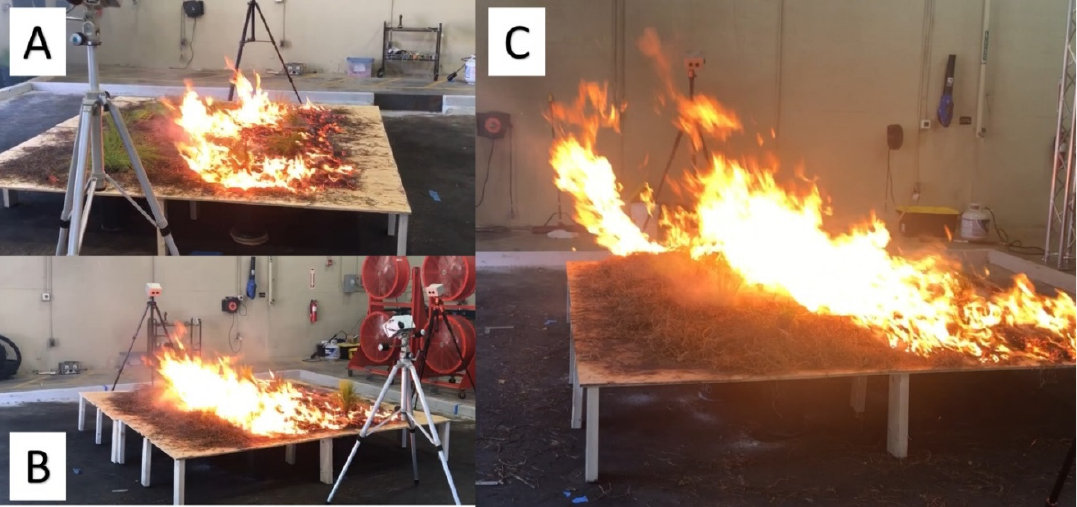
Figure 1. Low, medium, and high fuel loads after ignition. ( A ) Burn platform with 0.24 kg − 1 m − 2 of fuel, low fuel load (L). ( B ) Burn Platform with 0.49 kg − 1 m − 2 of fuel, medium fuel load (M). ( C ) Burn platform with 0.99 kg − 1 m − 2 of fuel, high fuel load (H).